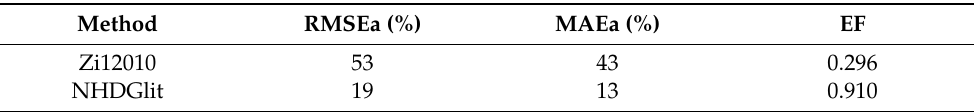
Table 8. Comparison of the proposed NDHG equation (NDHGlit) with the previously best- performing empirical equation. Method RMSEa (%) MAEa (%) EF Zi12010 53 43 0.296 NHDGlit 19 13